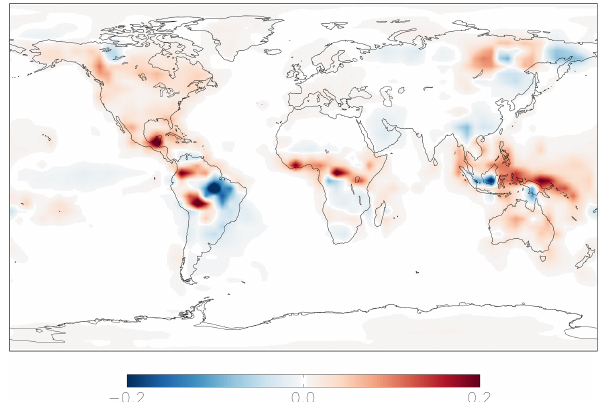
Figure 10. Modeled annual-mean difference in the fractional pro- duction rate of HNO 3 from the hydrolysis of organic nitrate below 1km attitude in the year 2015 relative to 2000